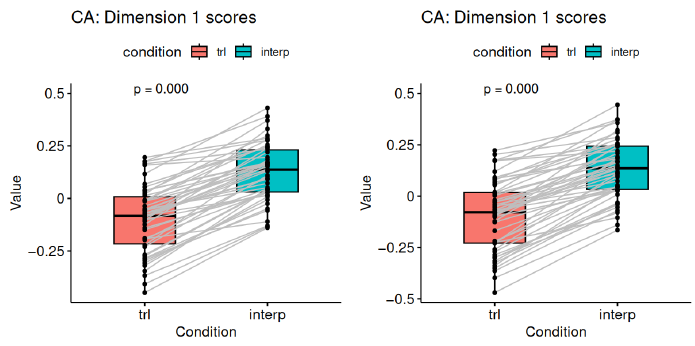
Figure 3. Comparison of row scores (texts) for Dimension 1 in a Correspondence Analysis of the POS-tag frequencies in translations and interpretations (left: basic tagset, right: extended